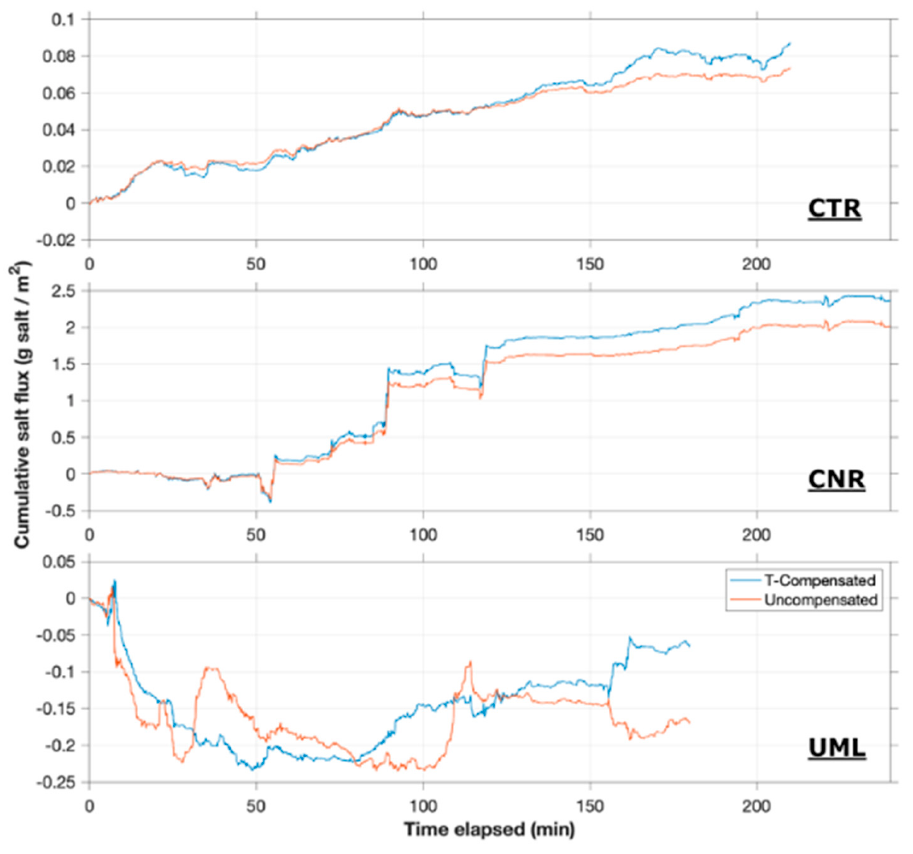
Figure 6. Cumulative eddy flux of salt at all sites. Blue traces are as calculated with temperature compensation, while red traces are fluxes based on raw electrical conductivity data.